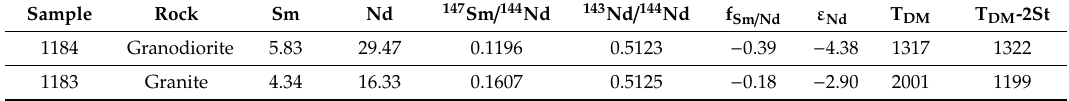
Table 7. Model Rb–Sr age and parameters of protoliths for EIRGD granitoids.